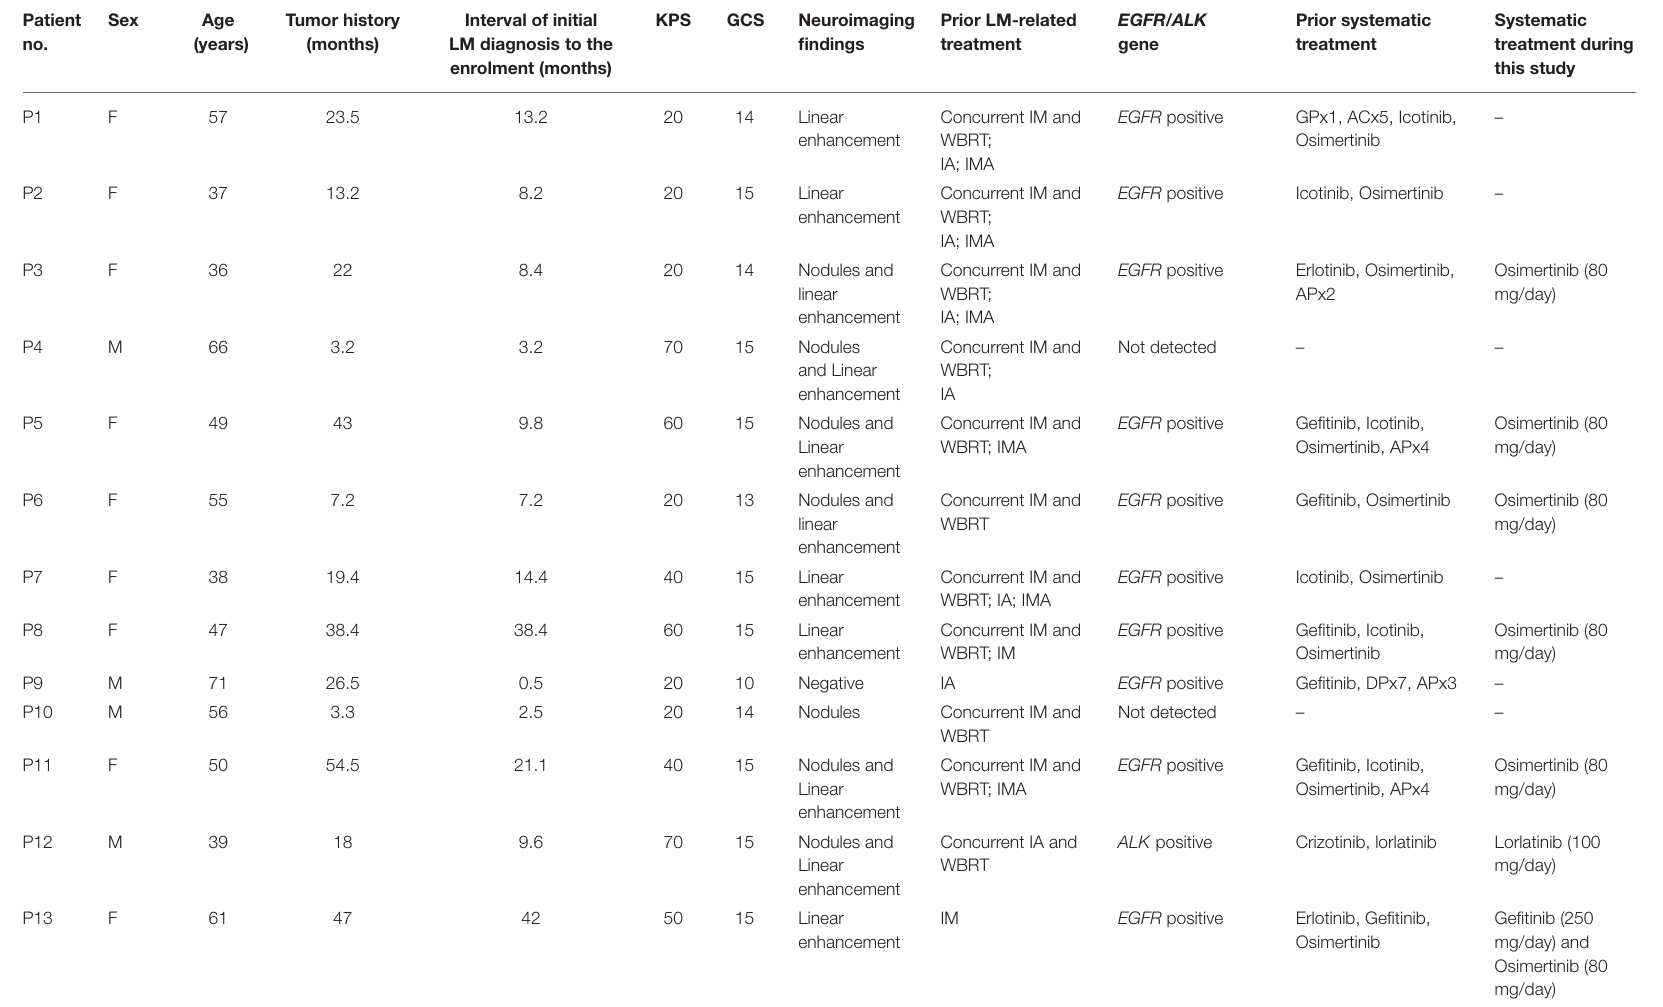
TABLE 1 | Patients’ general information. Patient